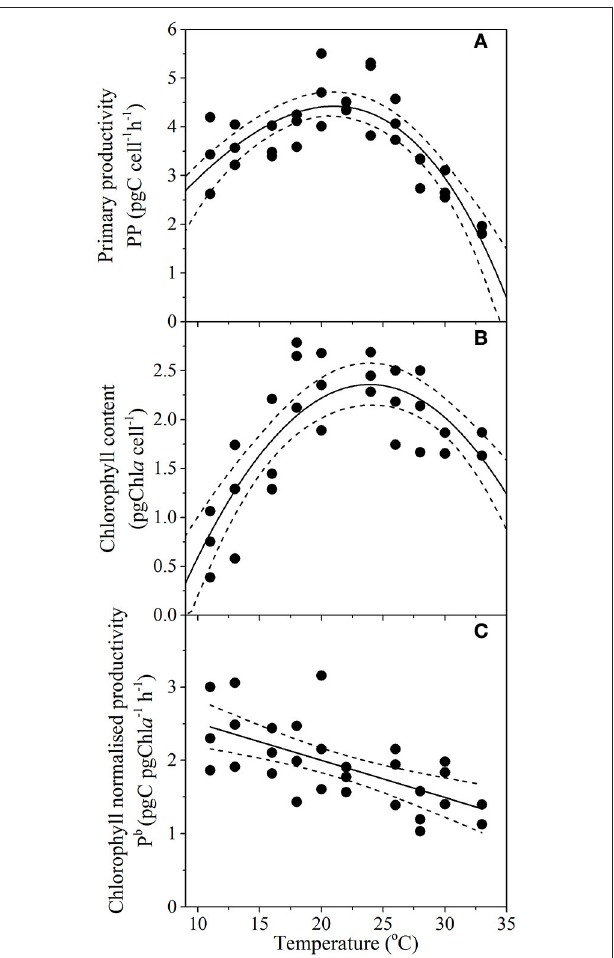
FIGURE 5 | Thermal performance curves of physiological traits in the diatom Thalassiosira pseudonana depicting (A) primary productivity ( n = 32, RSME = 0.5); (B) chlorophyll content ( n = 29, RSME = 0.4); and (C) chlorophyll normalized productivity ( n = 29, p < 0.01, R 2 = 0.44), as a function of temperature. Each symbol represents a distinct biological replicate. Solid lines correspond to maximum likelihood estimate with broken lines corresponding to the 95% confidence intervals of the (A,B) bell-shape function (Equation 1), and (C) linear regression, all estimated by parametric